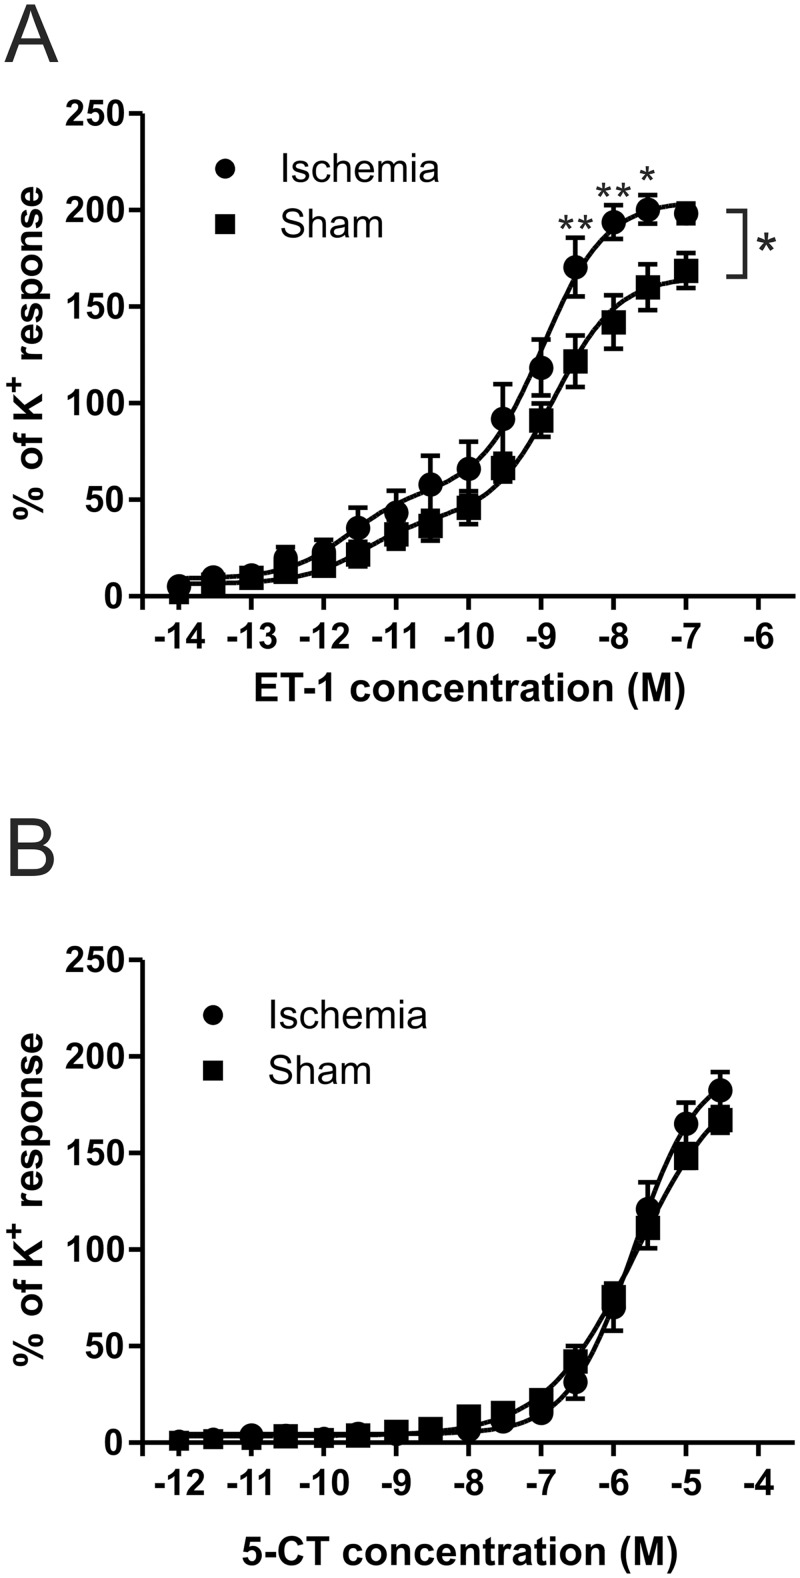
Increased endothelin-1 induced constriction after 48 hours.(A) Dose response curves for ET-1 on ischemic and sham ophthalmic artery 48 hours after ischemia are significantly different (p<0.05) with a left shift in the EC50. Sham EC50 was 1.56nM (pEC50 8.810±0.12M) and for ischemia it was 1.07nM (pEC50 8.97±0.13M). (B) 5-CT response curves are identical with EC50 1.91μM (pEC50 5.72±0.08M) for ischemia and EC50 2.09μM (pEC50 5.68±0.11 M) for sham.